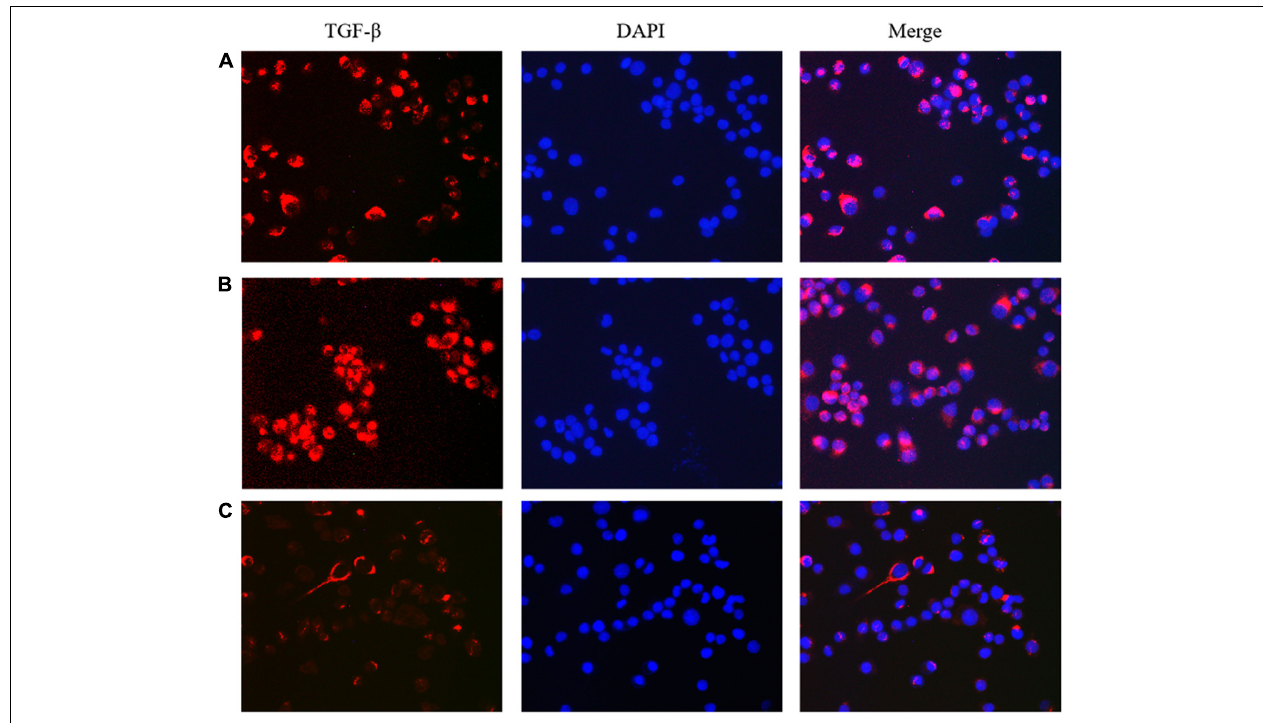
FIGURE 5 | The effect of lncRNA TPA overexpression and knockdown on the expression of MCF-7 TGF- β antibody [200 × , (A) Normal breast cancer cells, (B) lncRNA TPA overexpression cells, (C) lncRNA TPA knockdown cells].